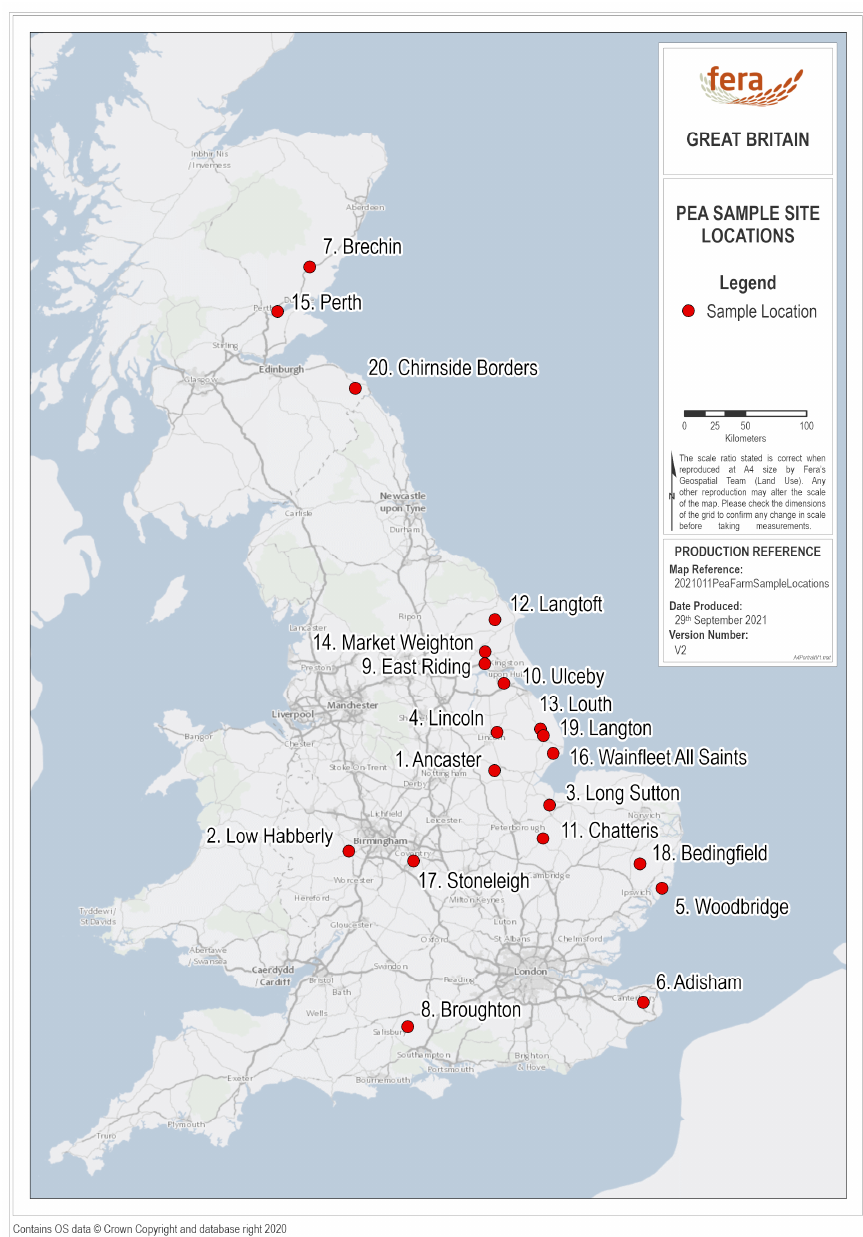
Figure 1. Map of mainland United Kingdom showing the approximate locations of the twenty pea field sites chosen for sampling, made using ArcGIS